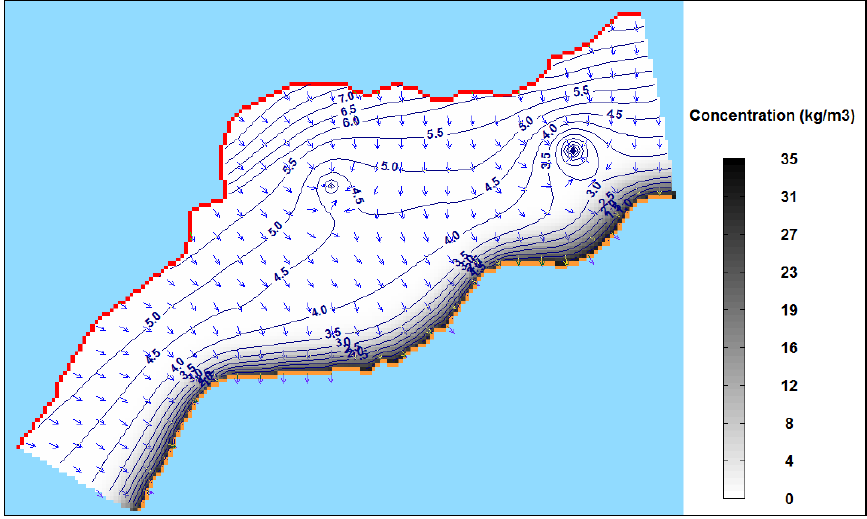
Figure 18. Groundwater piezometry in 2100 and concentration at the surface in layer 1 under the RCP 2.6 scenario.